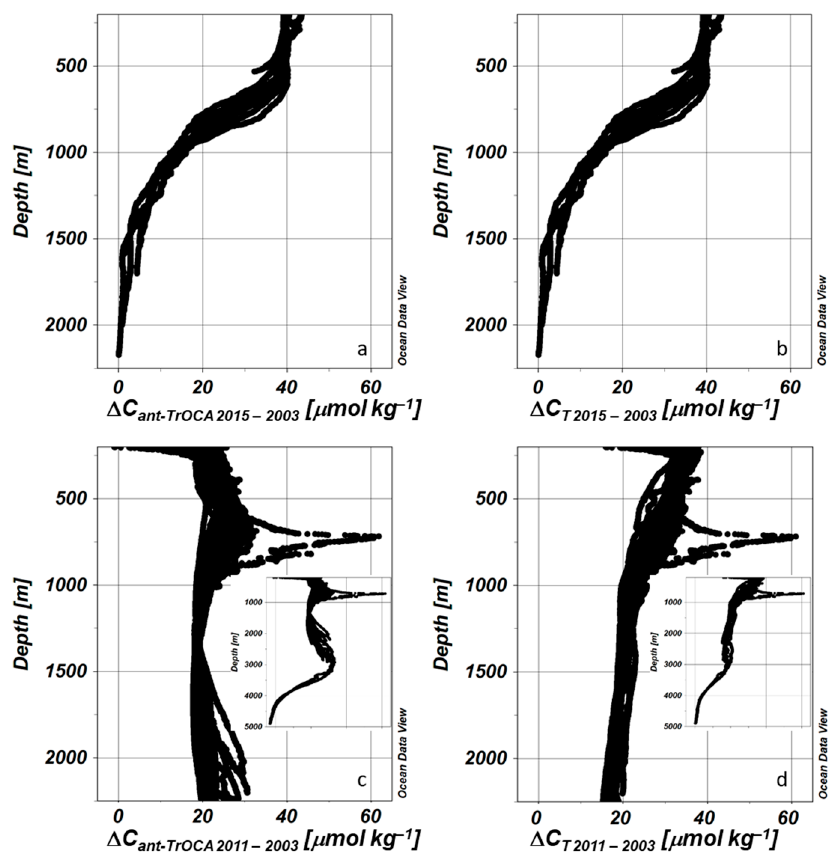
Figure 7. Vertical profiles of ∆ C ant-TrOCA (left panels) and ∆ C T (right panels); ( a , b ) FORSA cruise and ( c , d ) TAII cruise, where c and d include an inset panel denoting the entire water column depth below the surface mixed layer (200 m).